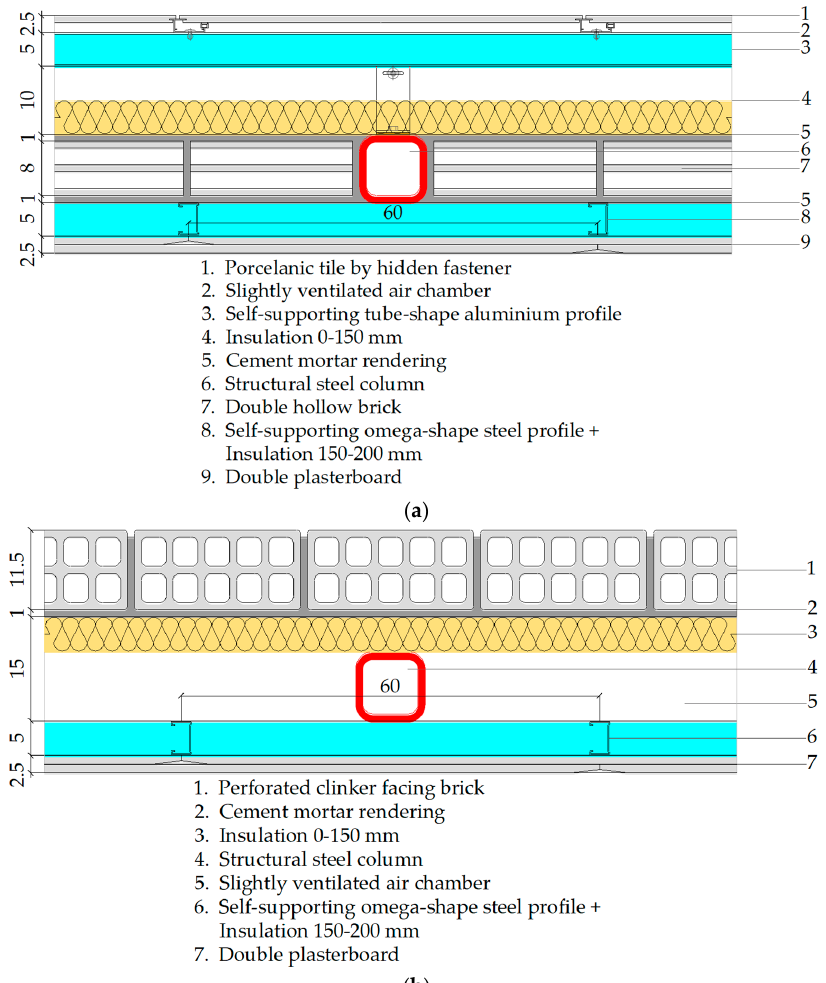
Figure A4. ( a ) Façade wall components detail for constructive solution 1 . ( b ) Façade wall components detail for constructive solution 2. Energies 2019 , 12 , x FOR PEER REVIEW